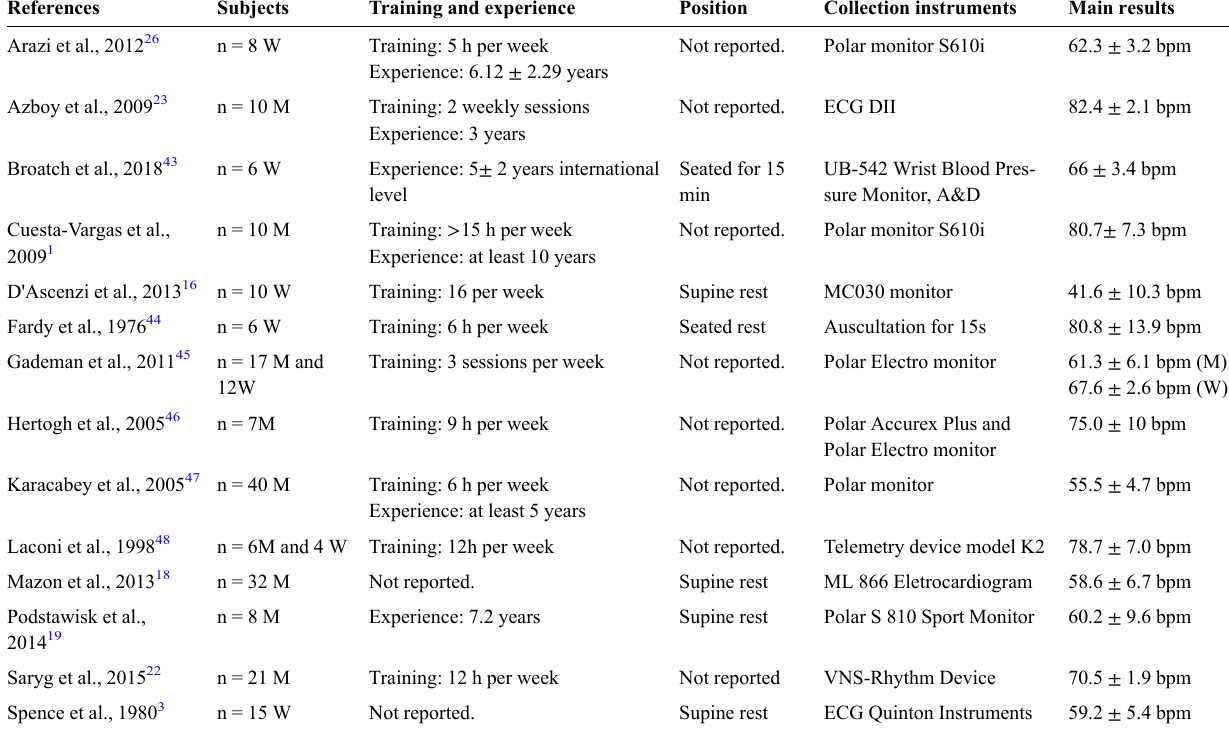
Table 1 - Studies included in the analysis of HRrest